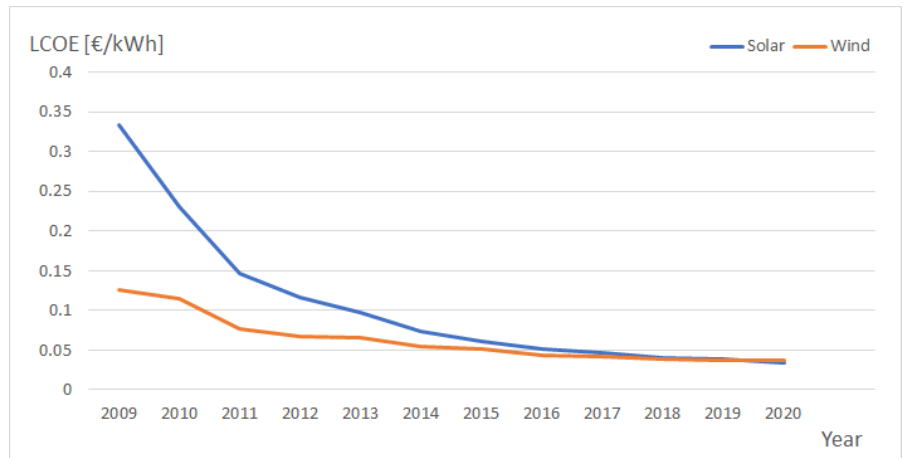
Figure 2. LCOE of wind and solar technologies. Adapted from [47].